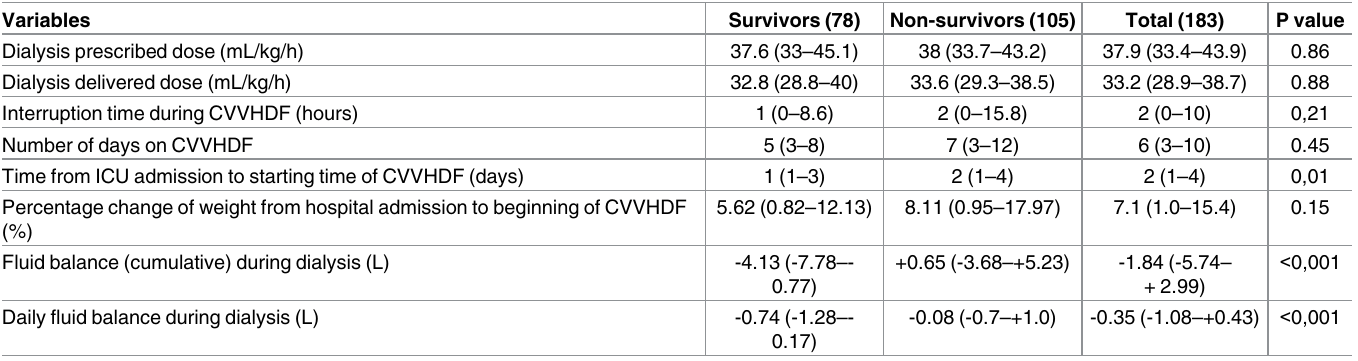
Table 2. Comparison of the aspects related to continuous dialysis between survivorsand